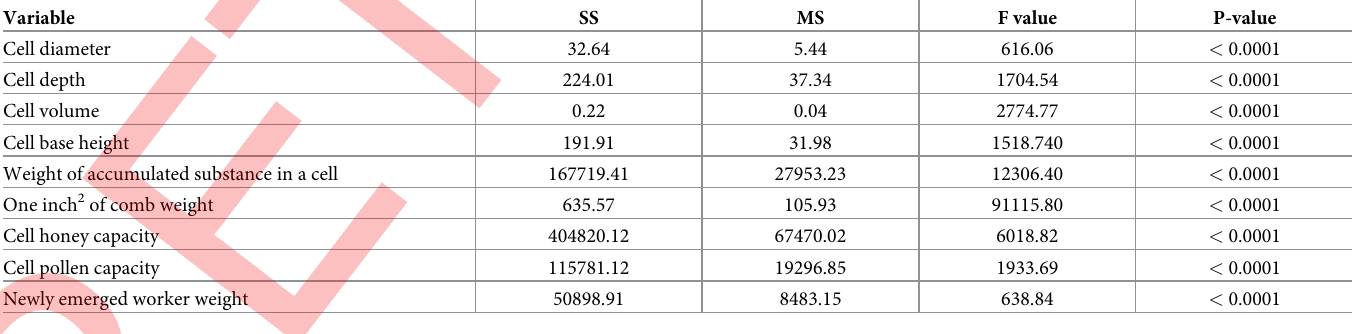
Table 1. Analysis of variance of measurements of comb cells and worker body weight. Variable